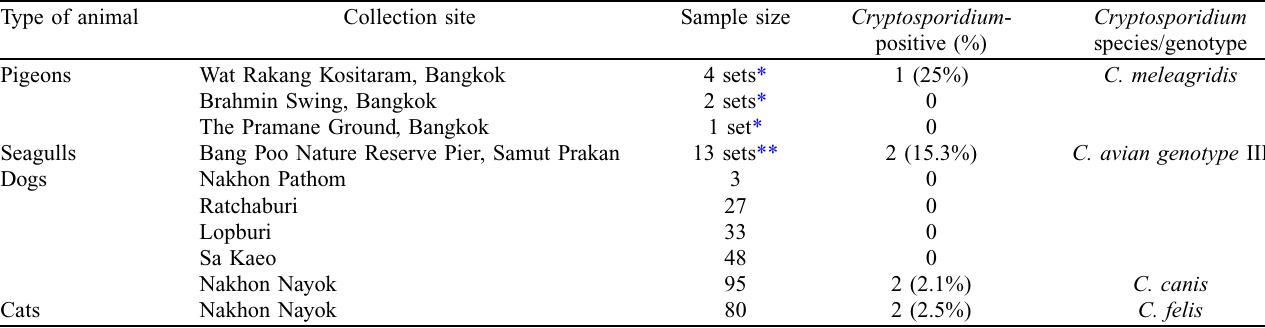
Table 1. Number of positive samples examined for Cryptosporidium for each collection site and the Cryptosporidium species/genotypes determined by PCR analysis of the SSU rRNA